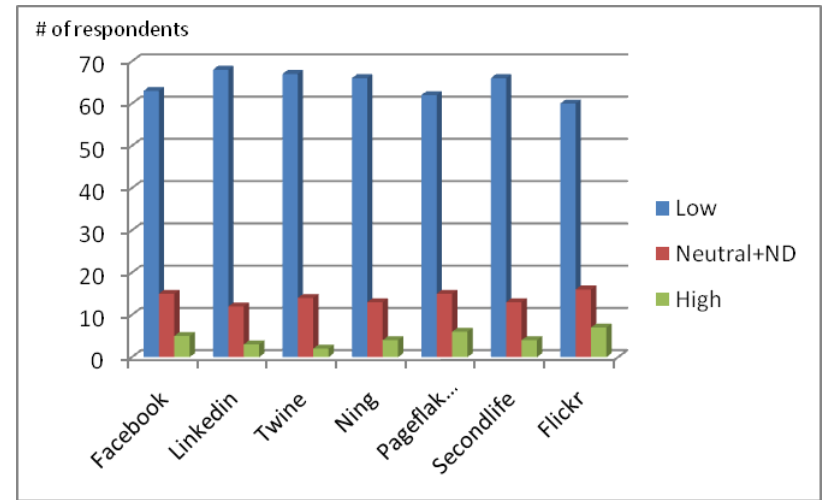
Figure 13 . Less relevant